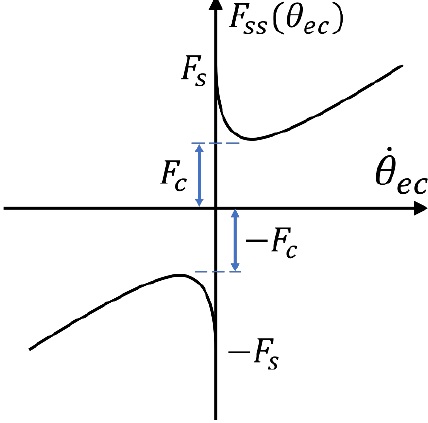
Figure 16. The steady-state friction function. Table 6. System parameters in mechatronic system.